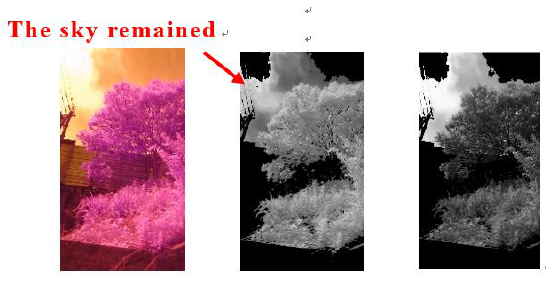
Figure 9. Threshold image using NIR band